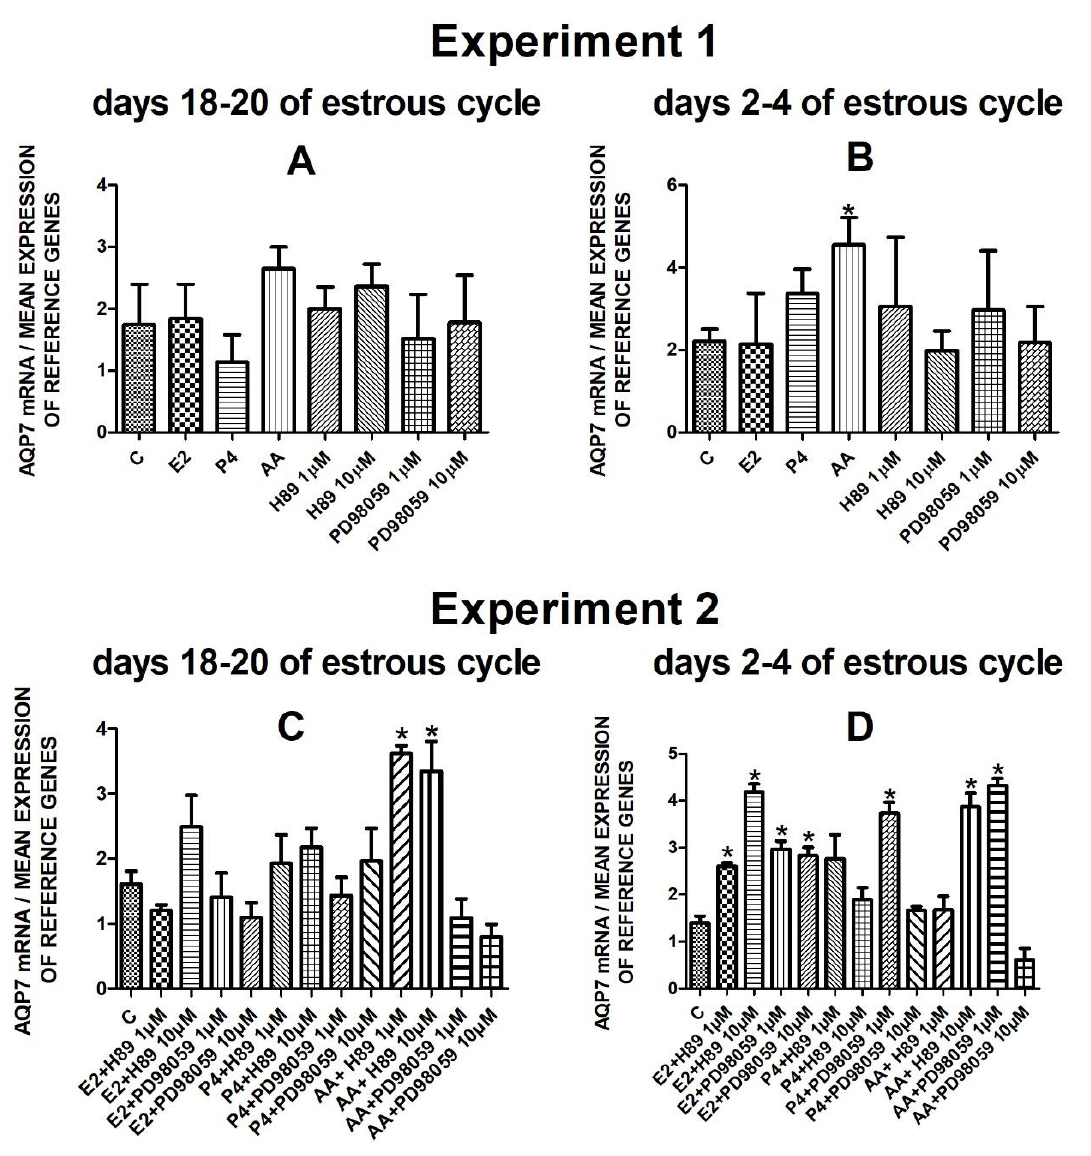
Figure 4. The influence of estradiol (10 nM), progesterone (10 − 6 M), arachidonic acid (10 − 5 M), and kinase inhibitors H89 (1 µ M, 10 µ M) and PD98059 (1 µ M, 10 µ M) and mix of these factors on Aquaporin 7 mRNA expression (Experiment 1: ( A , B ), Experiment 2: ( C , D )) in the porcine luminal epithelial cells from days 18–20 and 2–4 of the estrous cycle. The gene expression was determined by quantitative real-time PCR. Results are reported as the means ± S.E.M. ( n = 5). Bars with different superscripts differ ( p < 0.05) and are marked by (*). Table 3. A summary of the results from Experiment 1.